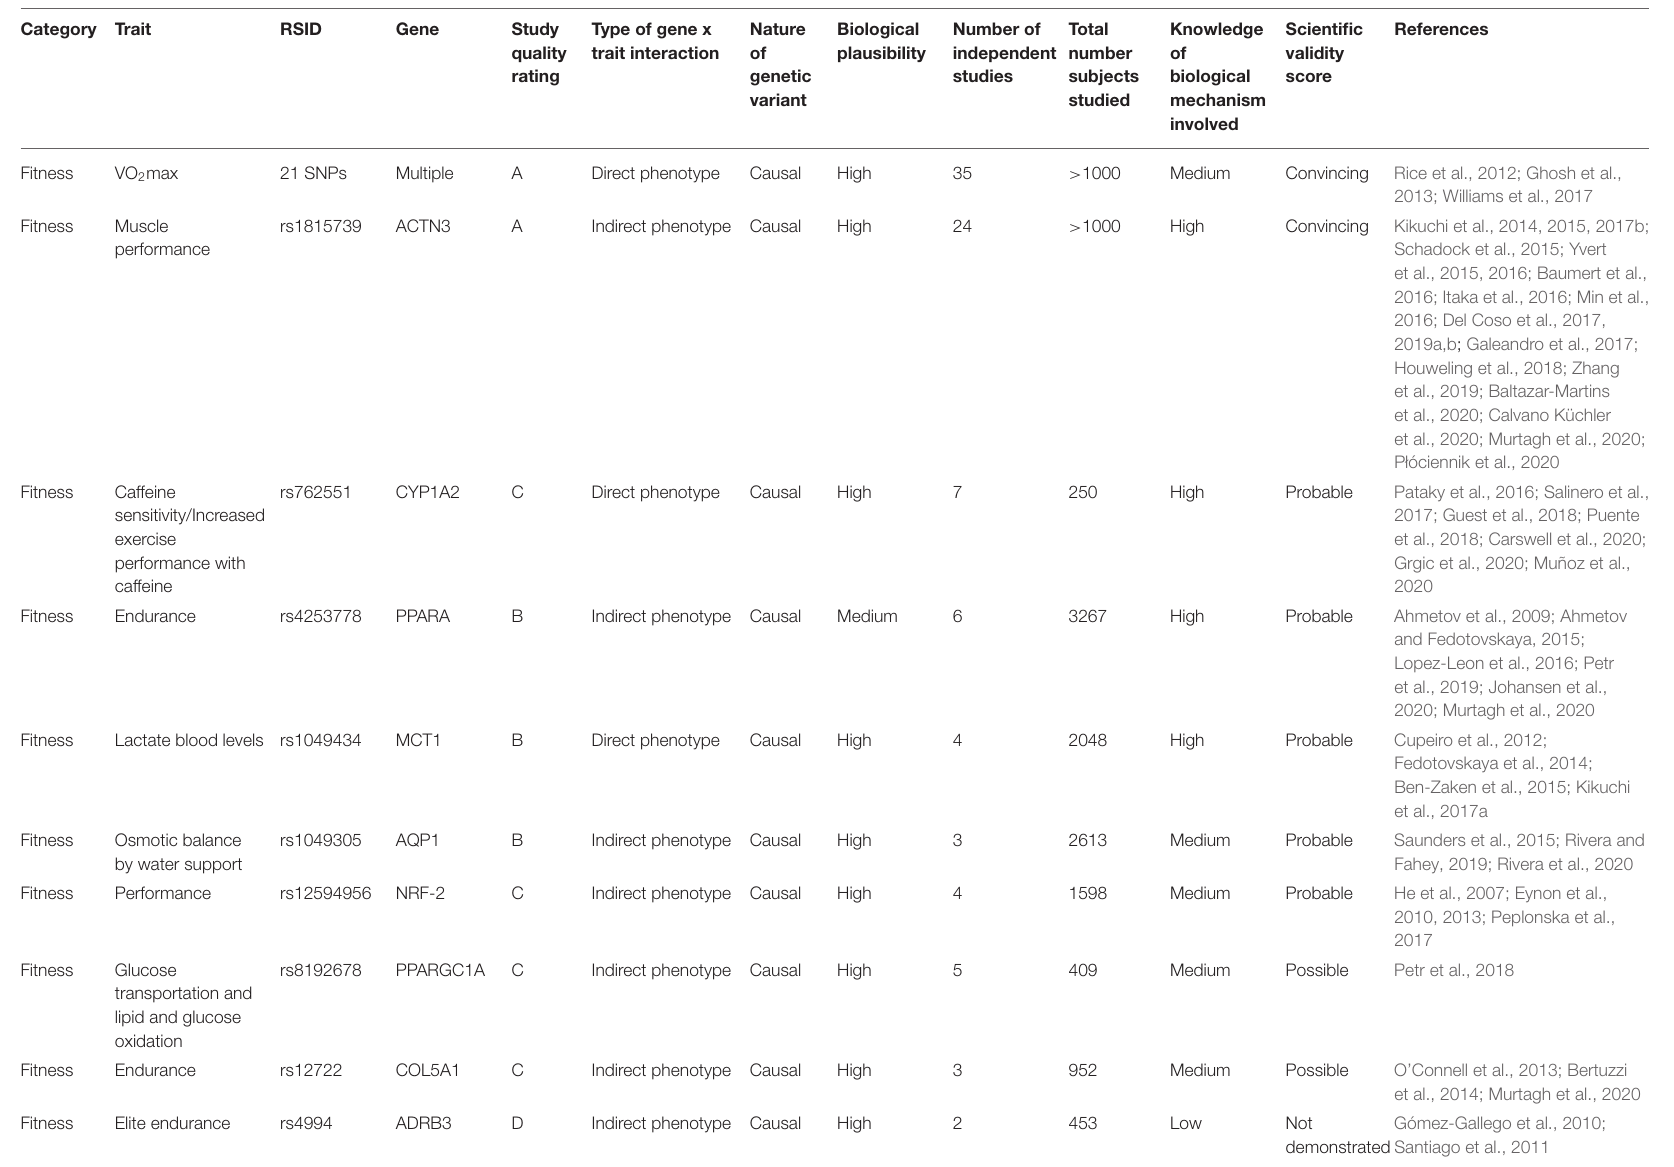
TABLE 3 | Summary of fitness trait analysis candidates assessed according to the scientific validity score as proposed by Grimaldi et al. (2017). Category